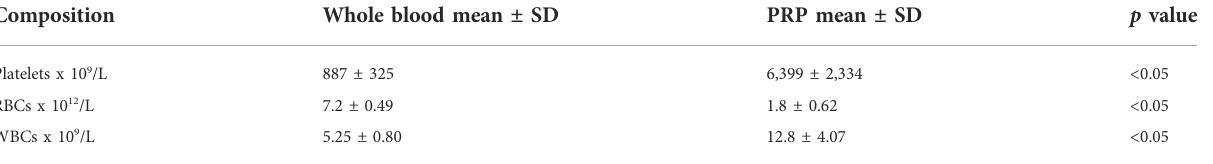
TABLE 2 Complete blood count of whole blood and PRP.